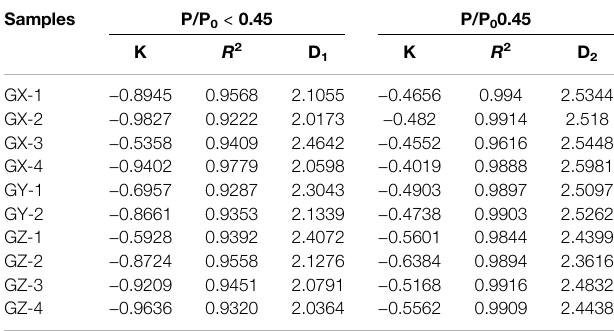
TABLE 3 | Fractal dimensions obtained from N 2 adsorption. Samples P/P 0 < 0.45